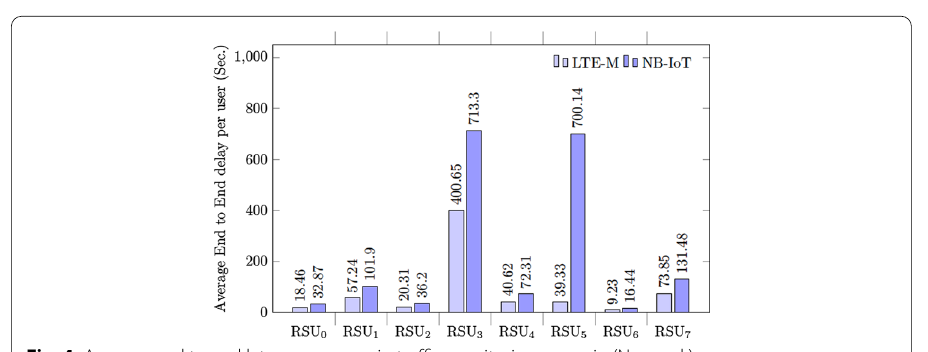
Fig. 4 Average end to end latency per user in traffic monitoring scenario